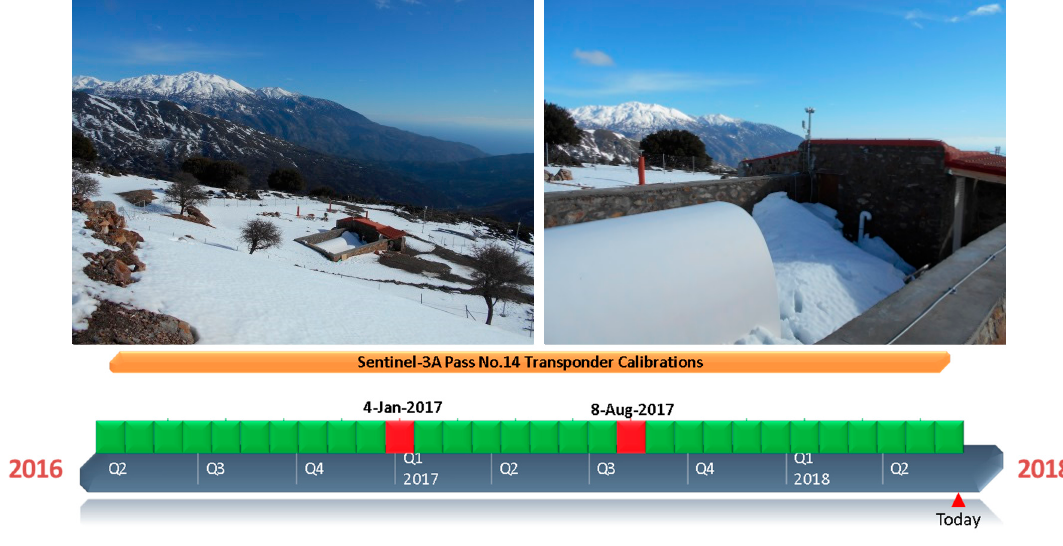
Figure 9. Timeline of Sentinel-3A Pass No.14 transponder calibrations at the CDN1 Cal/Val site. Green boxes represent successful calibration, whereas red boxes correspond to two calibrations canceled as a consequence of extreme weather conditions (4 January 2017, Cycle No.13, Images above) and site maintenance (8 August 2017, Cycle No.21).